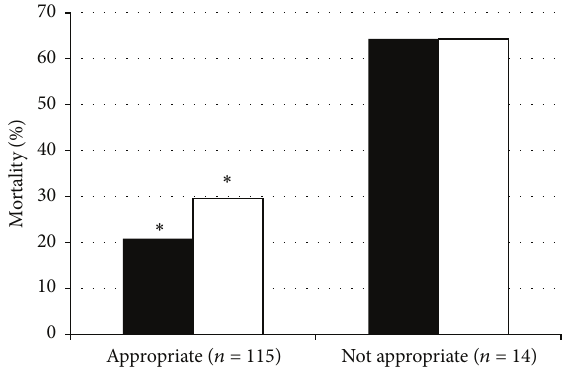
Figure 5: ICU and hospital mortality related to antibiotic appro- priateness based on culture results. Both ICU ( ◼ ) and hospital ( ◻ ) mortality were significantly less in the group that received initially appropriate empiric antibiotics for VAP ( ∗ 𝑝 < 0.02 for both). Data presented as